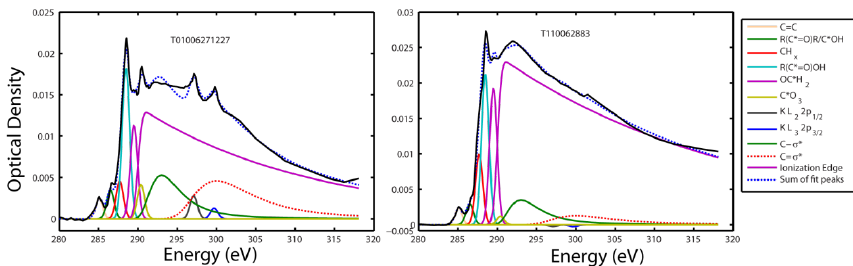
Fig. 9. Average NEXAFS spectra (black solid line) obtained from T0 on 27 June 2011, 12:27LST (left) and T1 on 28 June 2011, 16:18LST (right). Peaks from various transitions are indicated by colored solid Figure 9. Average NEXAFS spectra (black solid line) obtained from T0 on 6/27/2011 12:27 3 LST (left) and T1 on 6/28/2011 16:18 LST (right). Peaks from various transitions are 4 indicated by colored solid lines. 5